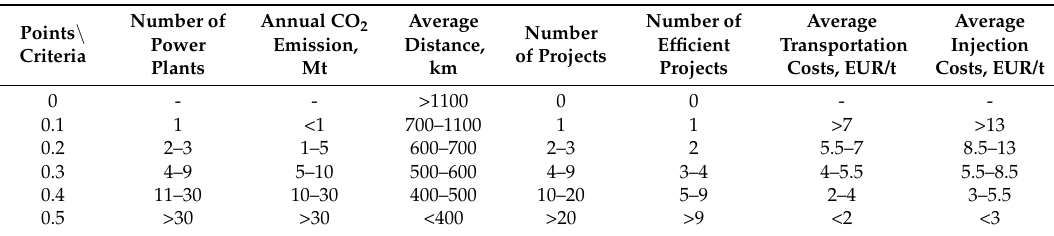
Table 3. Interval scale to rank regions according to their potential as CO 2